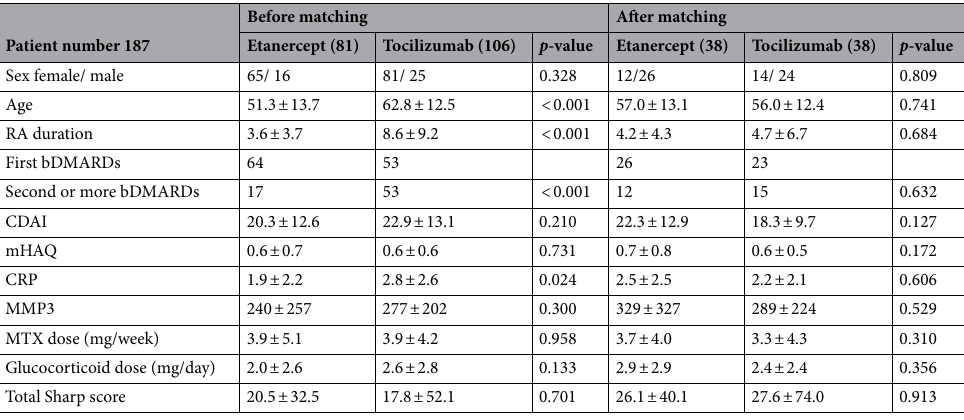
Table 1. Patient characteristics before and after propensity score matching. bDMARDs biological disease- modifying antirheumatic drugs, CRP C-reactive protein, MMP-3 matrix metalloproteinase-3, CDAI clinical